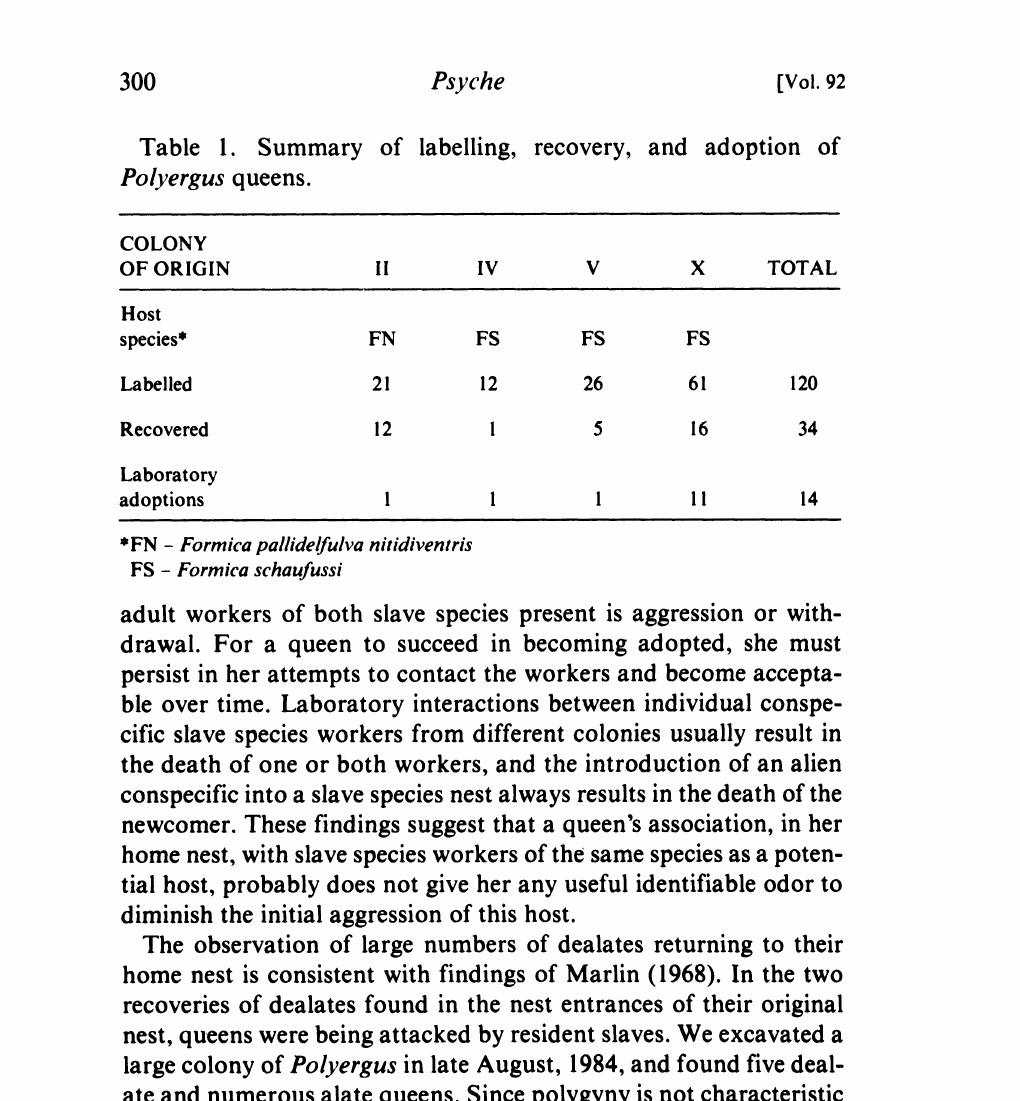
Table 1. Summary of labelling, recovery, and adoption of Polyergus